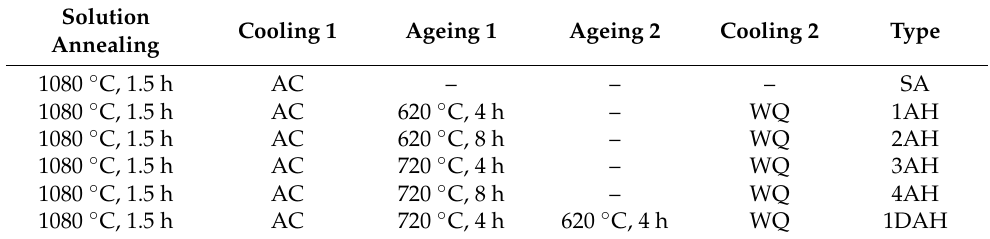
Table 4. Heat treatment cycles performed on Inc718 micro-LPBF samples.